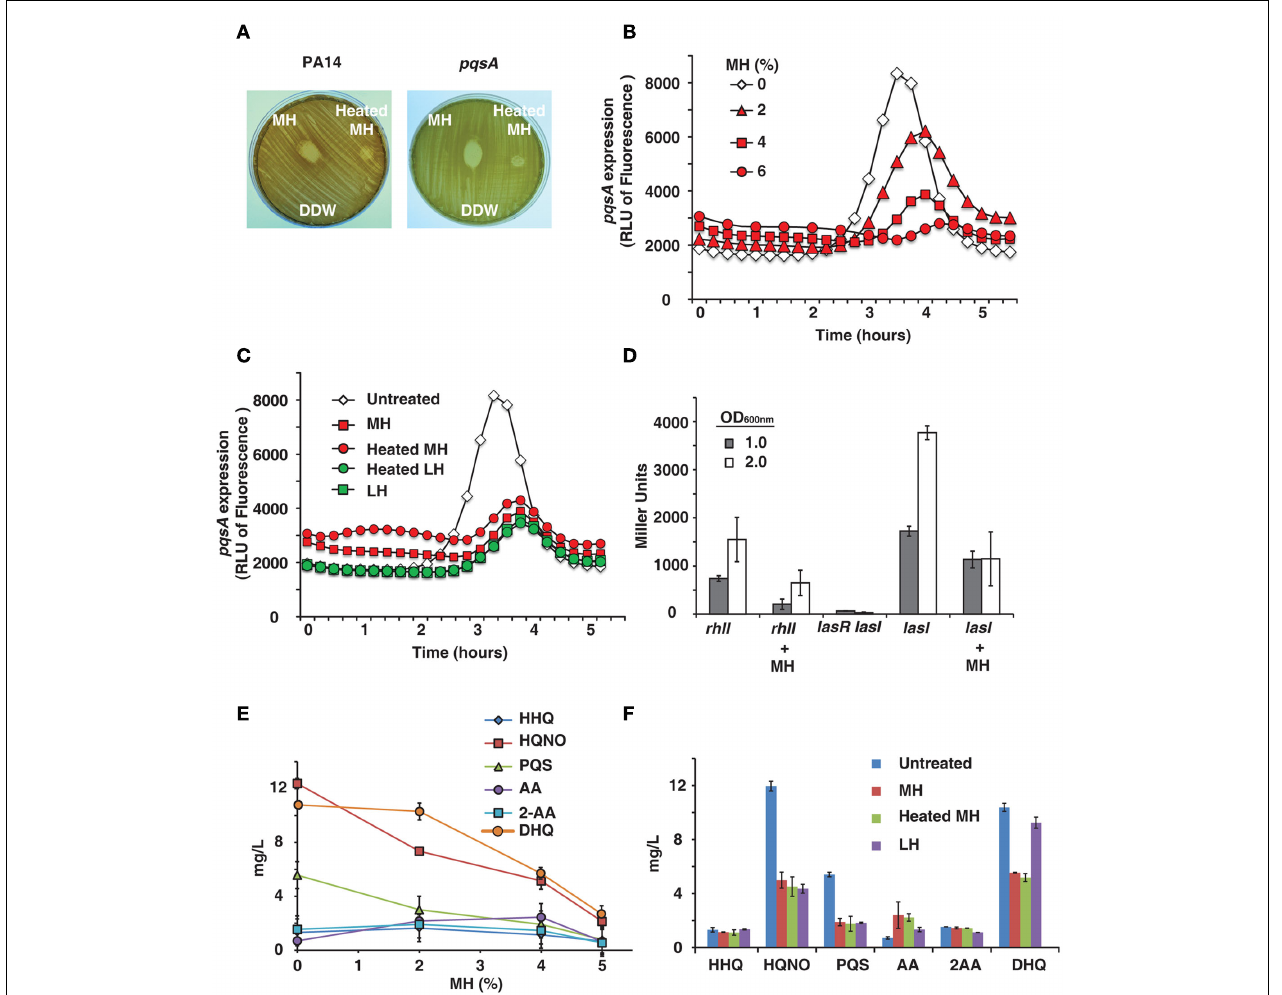
as in (A) , with all honeys diluted to 4%. Samples used were MH and local honey (LH), with and without heat treatment. (D) The expression of lasI and rhlI genes in the presence of honey was measured using a Miller β -galactosidase assay with PA14 cells expressing lasI or rhlI driven by the lacZ promoter and a lasR<lasI double mutant cells as a negative control. Measurements were taken at OD 600nm = 1.0 and 2.0 to determine gene expression at different cell densities. (E,F) Shows concentrations of MvfR low molecular weight QS-regulated molecules produced by the pqsABCD operon in the presence of honey. Samples used were MH and LH, with and without heat